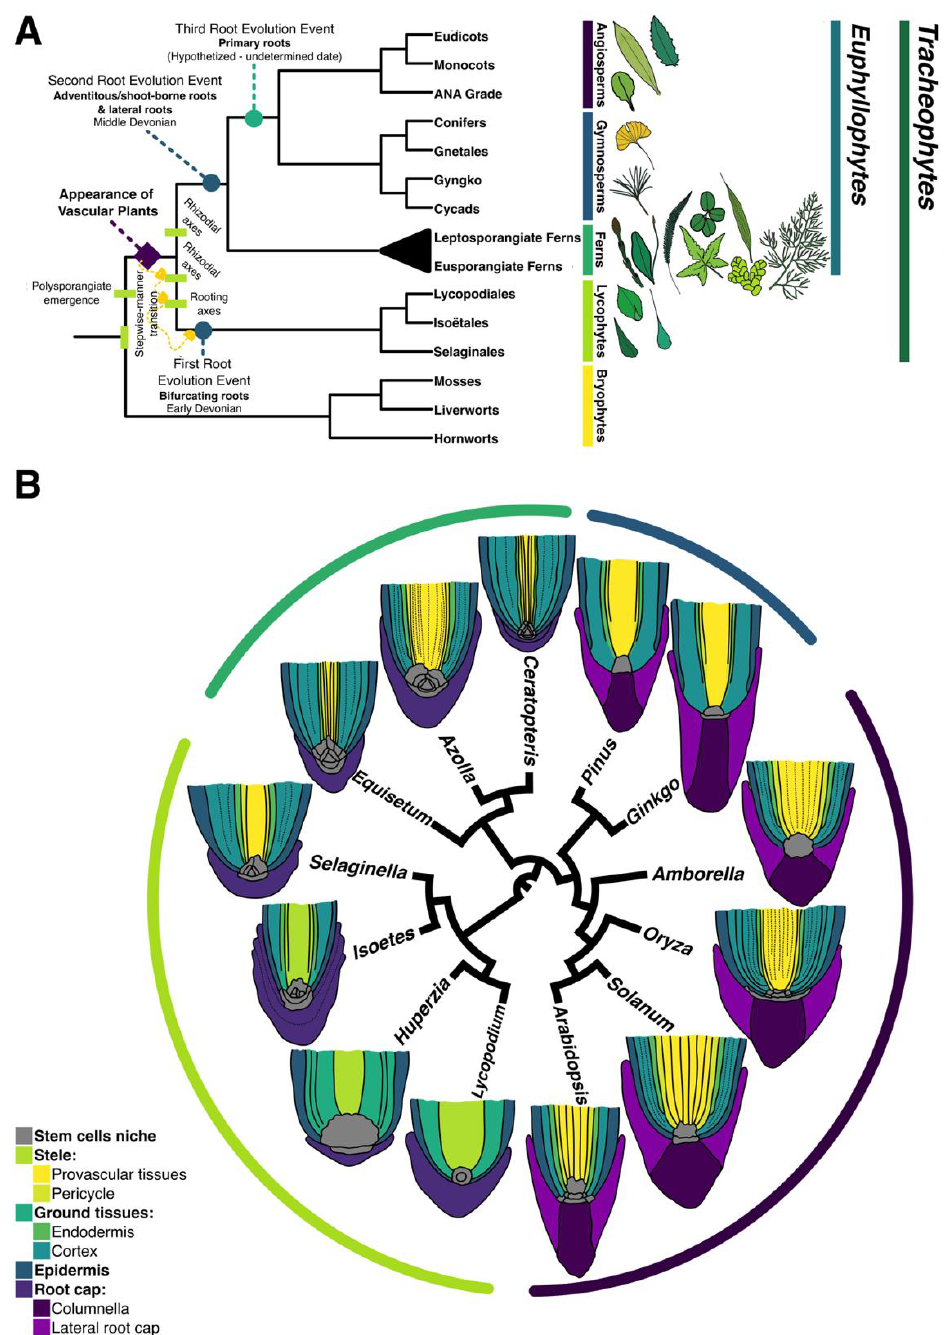
Figure 1. Evolution among major vascular plant lineages and its relation to root meristem organization. ( A )Hypothesisofrootevolutioninvascularplants. Bothmajorextantvascularplantlineages, lycophytes and euphyllophytes, have been hypothesized to independently evolve roots. Based on [3,4,6,15–18]. ( B ) Schematic representation of cell layer organization and stem cell niches in di ff erent described roots from extant vascular plants (Table S1). Meristem diversity has been extensively assessed across flowering plants, but not in other lineages. Color lines covering the roots, correspond to color patterns represented in A. The di ff erent RAM morphologies showed in Figure 1B were obtained from published articles. The scientific name of each species, its plant lineage and the corresponding reference can be found in Table S1 in Supplementary Materials.